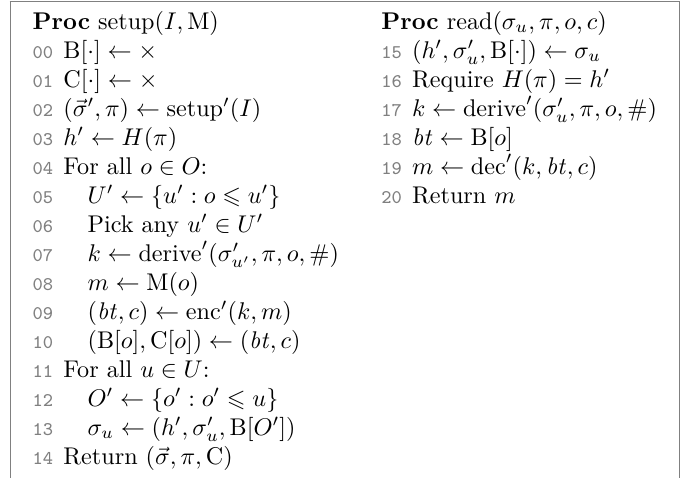
Figure 5: Our ROES construction roes with procedures setup , read using procedures setup 0 , derive 0 of a generic KAS kas and procedures enc 0 , dec 0 of a generic encryptment scheme enc. In [00,01] we encode uninitialized values with × . In [07,17] we write # for any fixed associated-data